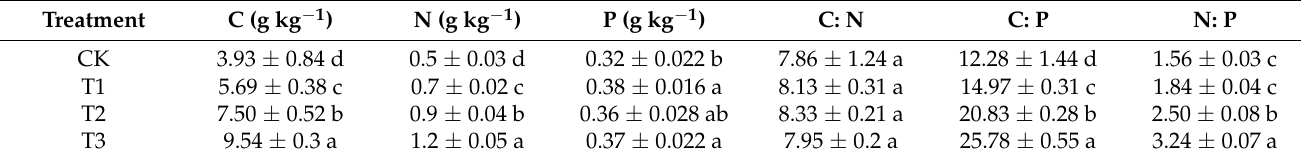
Table 1. The change of Stoichiometric Characteristic Values of Soil under different treatments, the data is the average value of stoichiometric characteristic values from June to October under the same treatment (mean ±